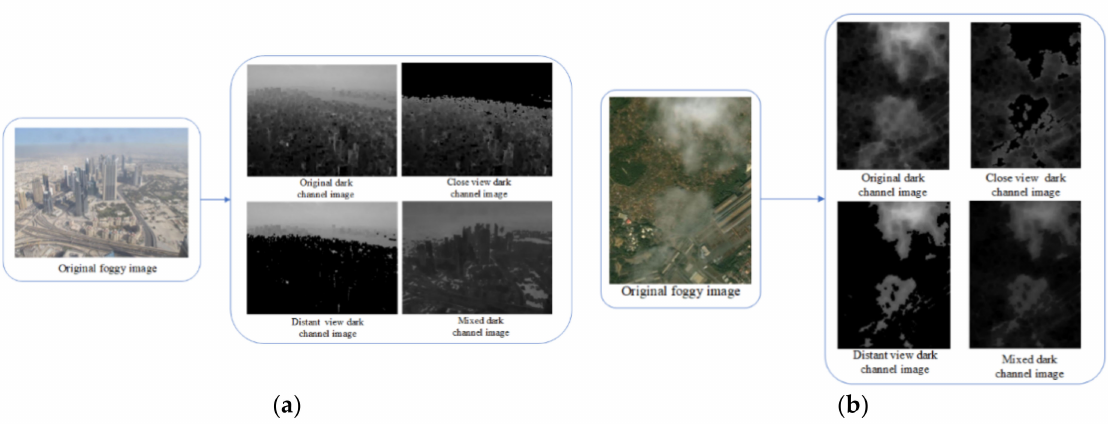
Figure 4. Comparison of traditional and mixed dark channel ( a ) Urban foggy image; ( b ) Satellite remote sensing